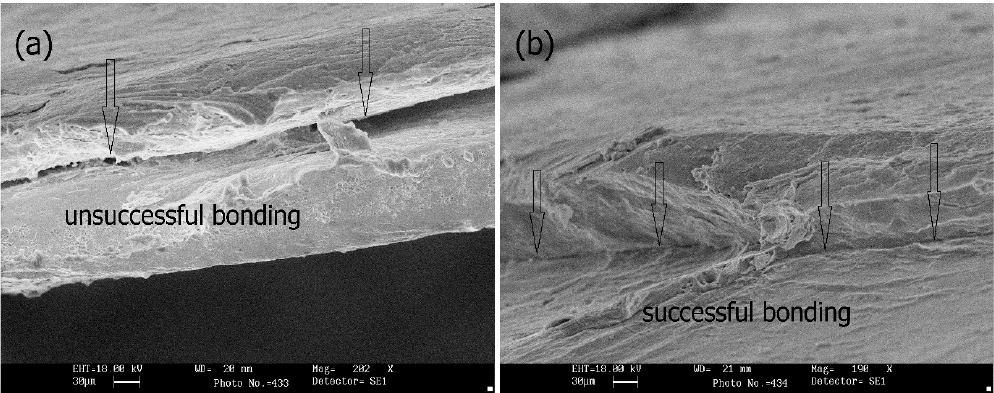
Figure 12. SEM images of the fracture surface around the interface of Al/Cu layers after the tensile test with ( a ) 10%, and ( b ) 30% of thickness reduction.